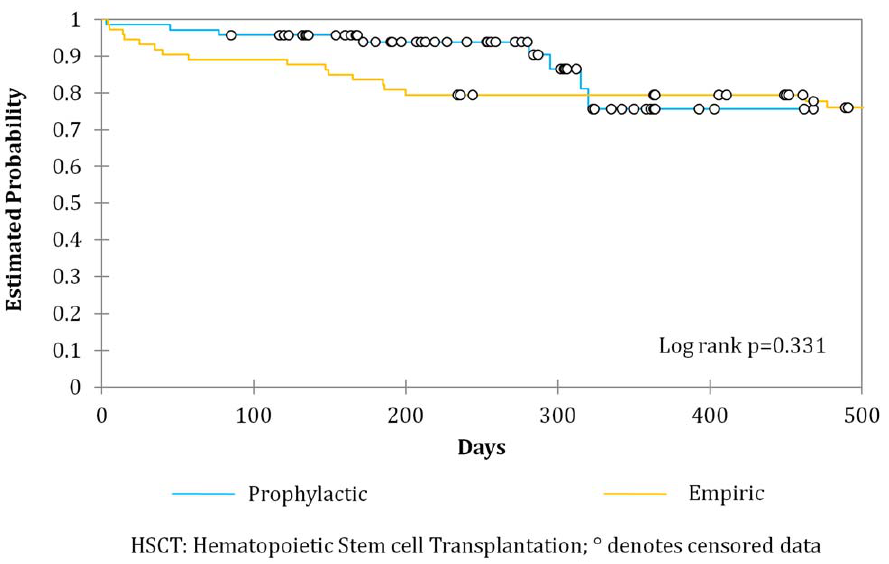
Figure 3. Overall Survival for patients undergoing autologous Hematopoietic Stem cell Transplantation receiving either a prophylactic or empiric antibiotic strategy.